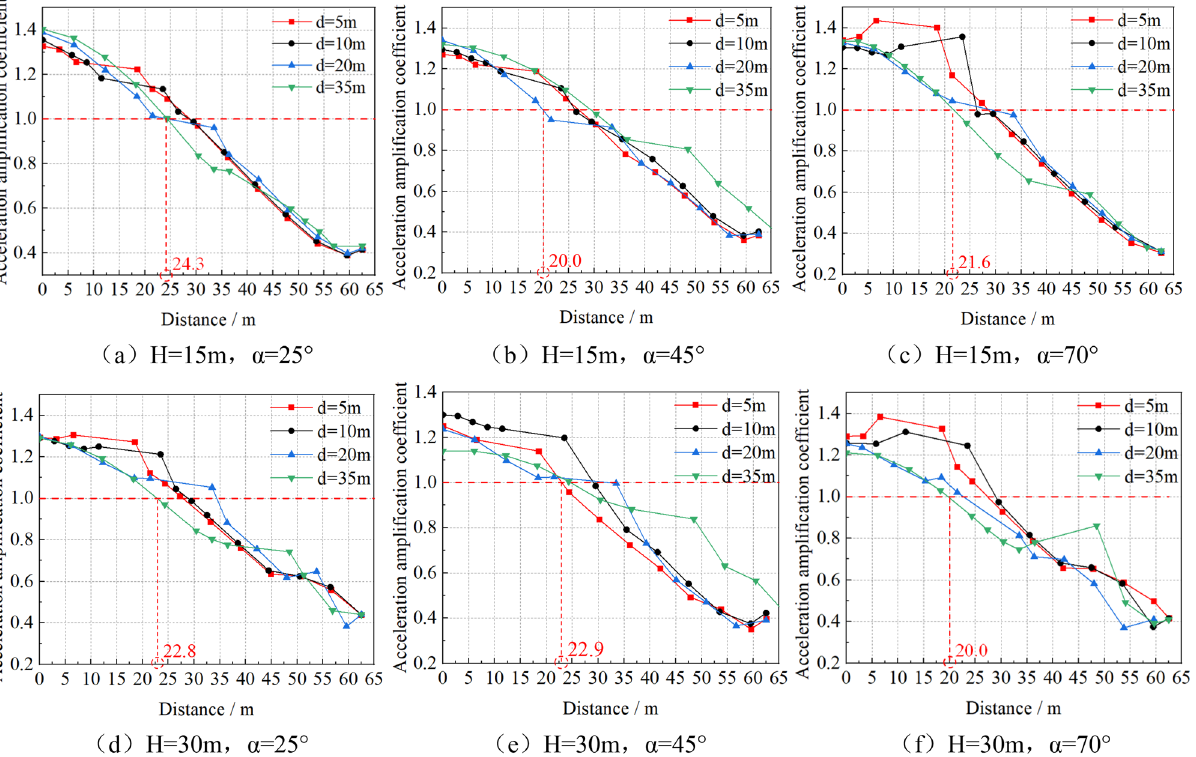
Figure 10. Acceleration amplification coefficient at the top of slope VS distance from slope shoulder.